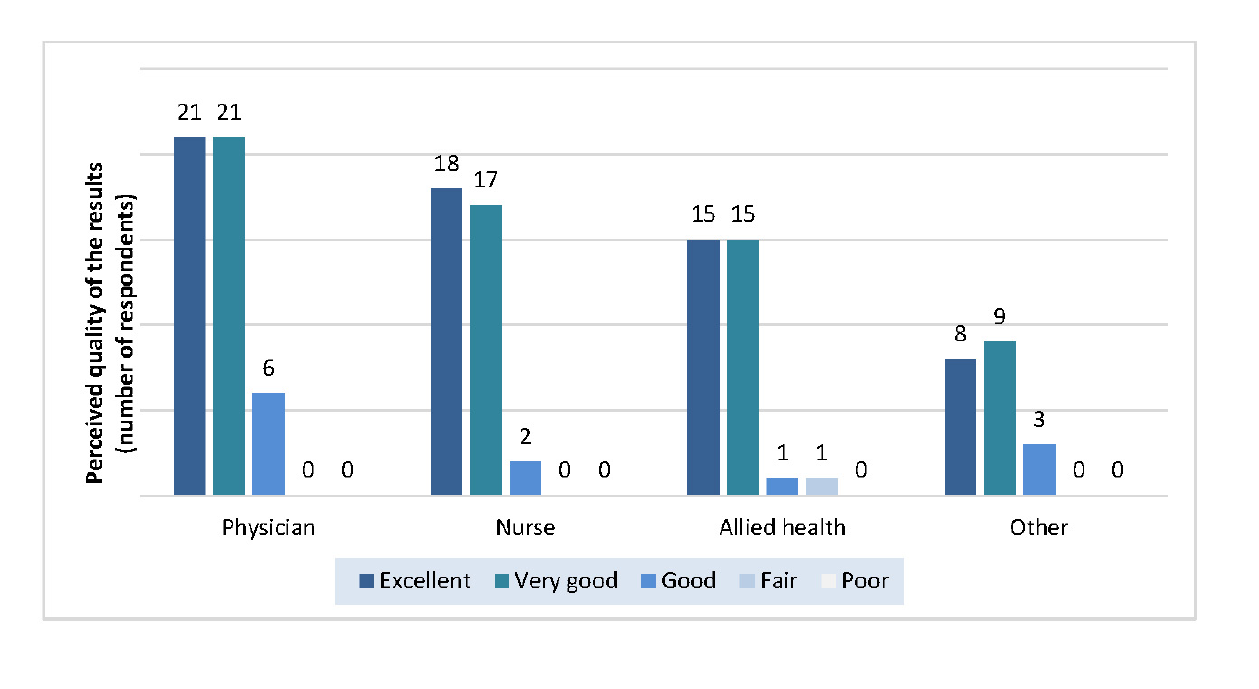
Figure 5 Perceived quality of the search results by professional designation